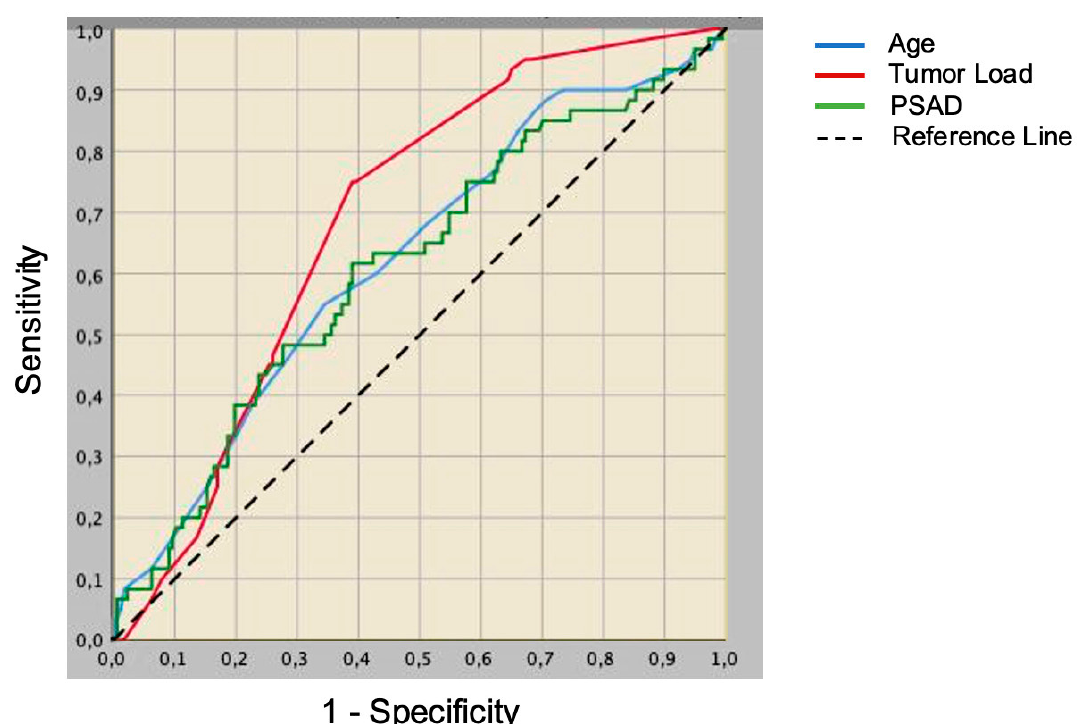
Figure 2. Receiver operating characteristic (ROC) curves of continuous variables predicting unfavor-